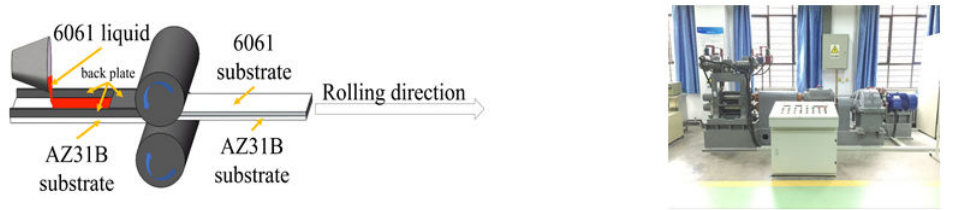
Figure 1. Schematic diagram of SLCRB of 6061/AZ31B composite plate and two-roller hot and cold